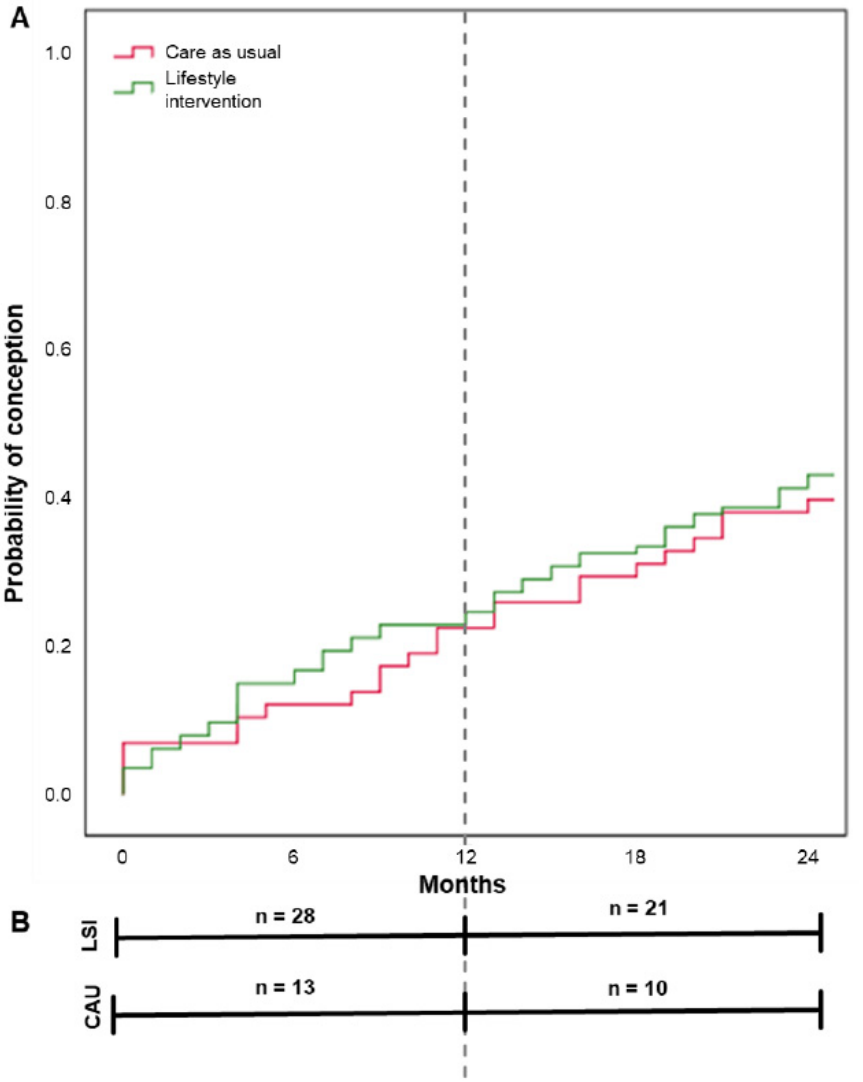
Figure 2. Time from the start of the study to conception resulting in live birth by group. Note: Results are based on calculations by the Erasmus MC using non-public microdata from Statistics Netherlands. ( A ) shows the Kaplan–Meier curve with mean time to conception resulting in live birth for lifestyle intervention (18.7 months), and care as usual (19.4 months). Differences were tested with